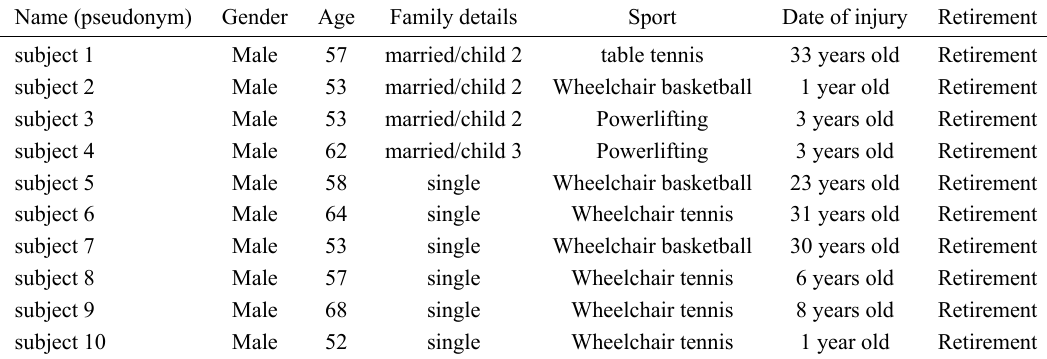
Table 1. The participants’ demographic and sociological